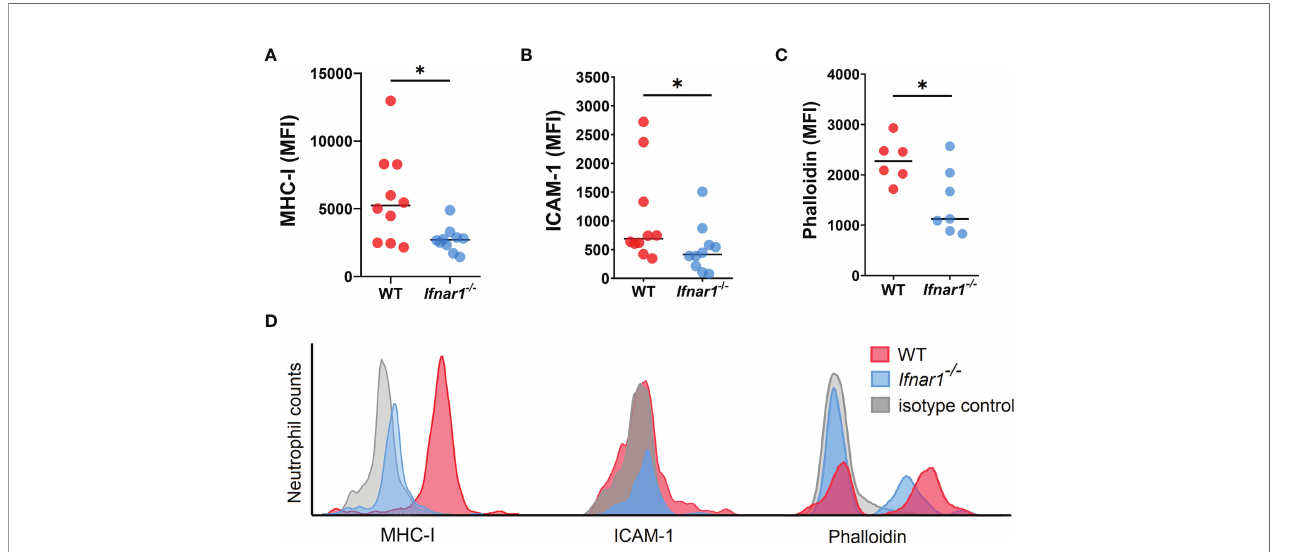
FIGURE 3 | Neutrophils in fi ltrating TDLNs in tumor-bearing Ifnar1 -/- animals show decreased expression of molecules involved in T-cell stimulation. (A, B) Downregulated expression of MHC-I and ICAM-1 on TDLN neutrophils from Ifnar1 -/- animals. (C) Signi fi cantly lower levels of F-actin on TDLN neutrophils from Ifnar1 -/- mice. (D) Representative histograms showing down-regulated expression of MHCI, ICAM-1 and phalloidin in neutrophils (single alive CD11b + Ly6G + cells) of tumor-bearing Ifnar1 -/- mice in comparison to WT mice. Tumor cells were injected s.c. into the right fl ank of mice. Mice were sacri fi ced on day 14 post tumor induction, LNs were collected, LN cells were stained for mentioned markers and analyzed by fl ow cytometry. Representative results from two replicate experiments are shown for (A, B) , n=10 for each cohort, and two replicate experiments are shown for (C) , n=6 for WT, n=7 for Ifnar1 -/- . For comparison of two independent groups, Mann-Whitney U test was used. Data are shown as an individual values with median. *p <